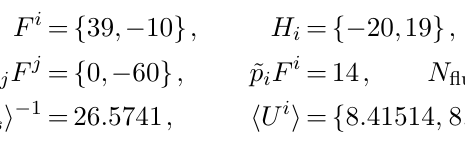
50 n where n = { 1 , 2 , . . . , 10 } . flux ≤